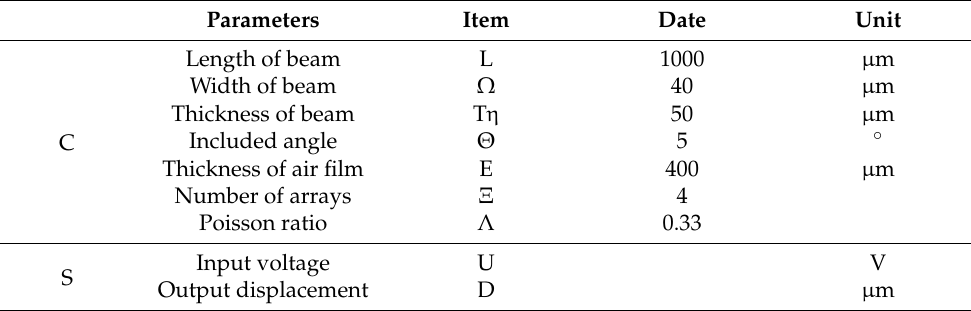
Table 2. Basic parameters after classification of V-shaped electro-thermal actuator. Parameters Item Date